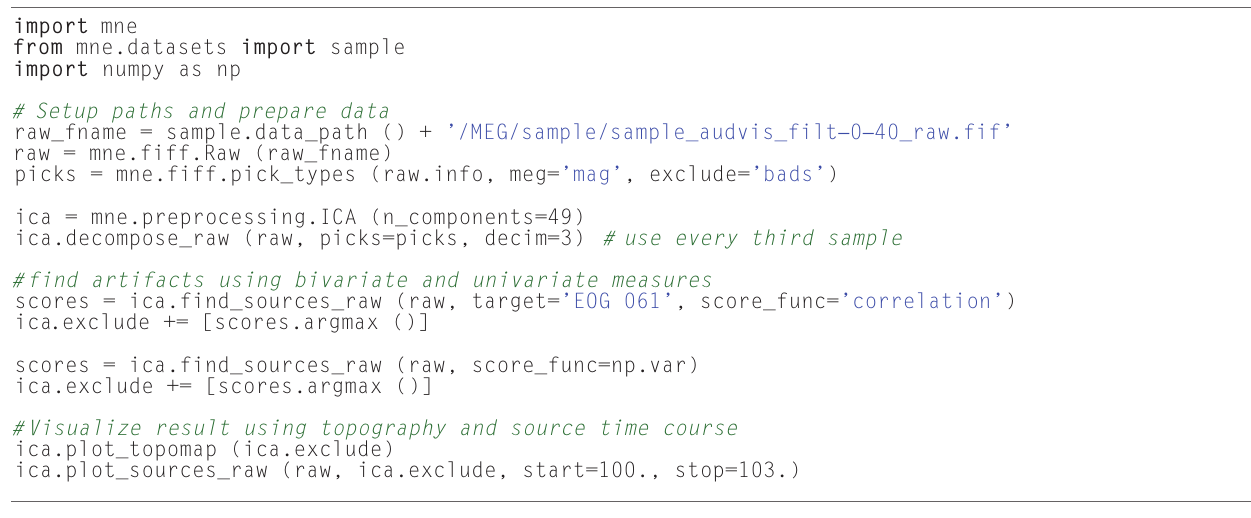
Table 2 | From epochs to ICA artifact removal in less than 20 lines of code. import mne from mne.datasets import sample import numpy as np # Setup paths and prepare data raw_fname = sample.data_path () + ’/MEG/sample/sample_audvis_filt − 0 −